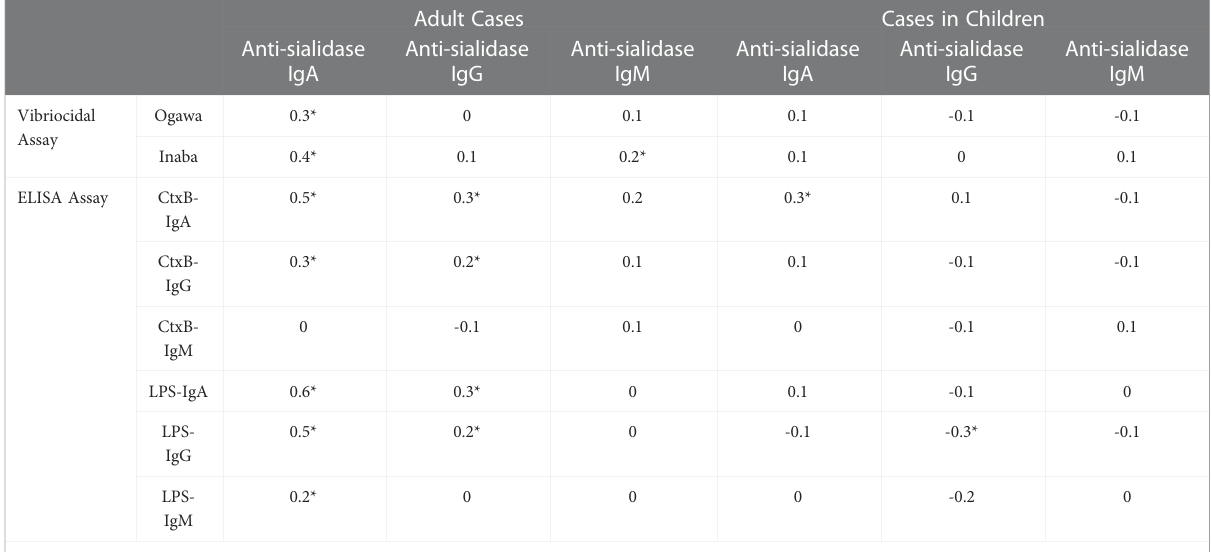
TABLE 2 Correlations matrix showing correlations between anti-sialidase responses and others immunological